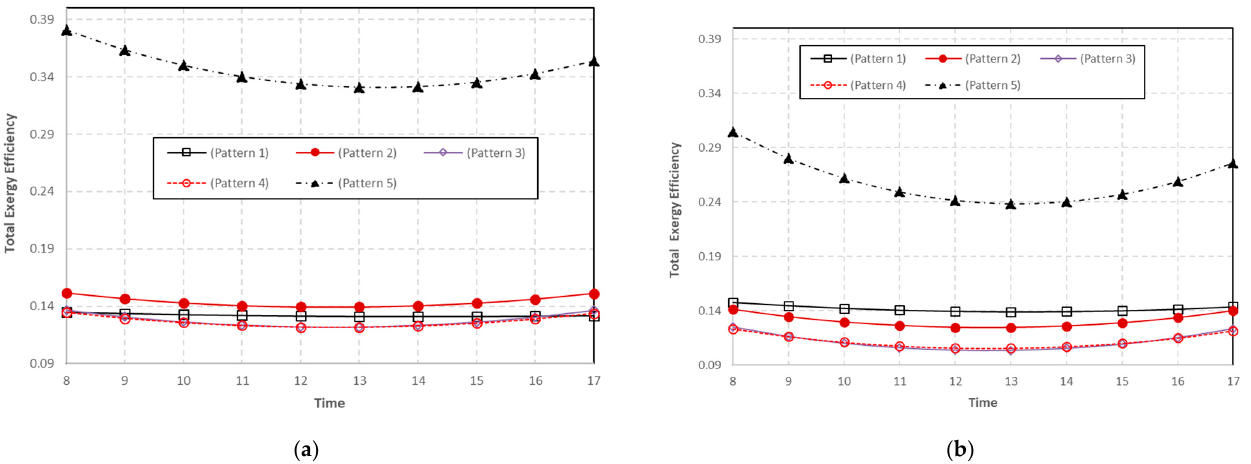
Figure 18. Hourly variations in the total exergy efficiency of PVT system for different configurations. ( a ) during Winter day ( b ) during Summer day.